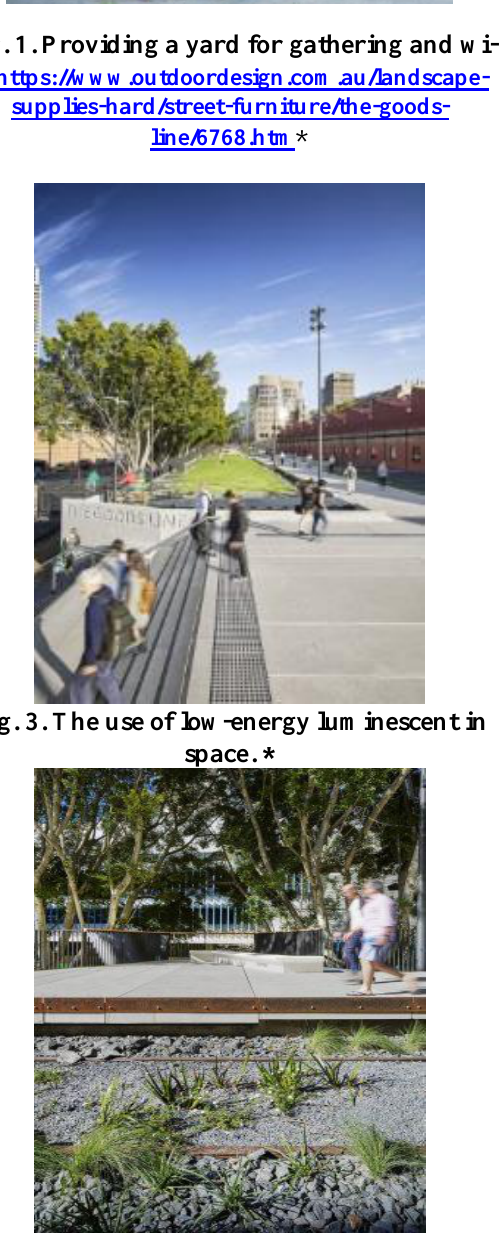
Fig. 6. The harmony of the materials and Fig. 5. Dealing with old structures such as color of the furniture within the space. railways. *